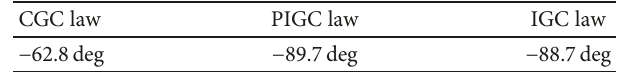
Table 2: Impact angle under the three control laws against a fi xed